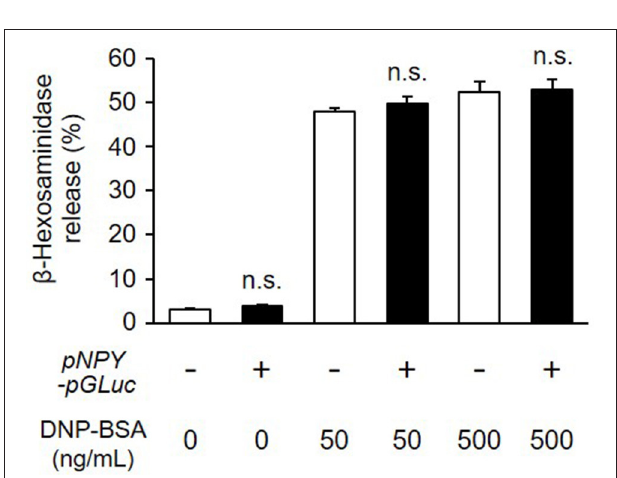
FIGURE 2 | Release of β -hexosaminidase from RBL-NPY-GLase cells by antigen stimulation. Percentages of released β -hexosaminidase to total contents in the cells stimulated with DNP-BSA for 30min were compared between wild-type cells (open bars) and RBL-NPY-GLase cells (closed bars). Data represent the means ± SD ( n = 4, n.s. means no significance vs. wild-type).